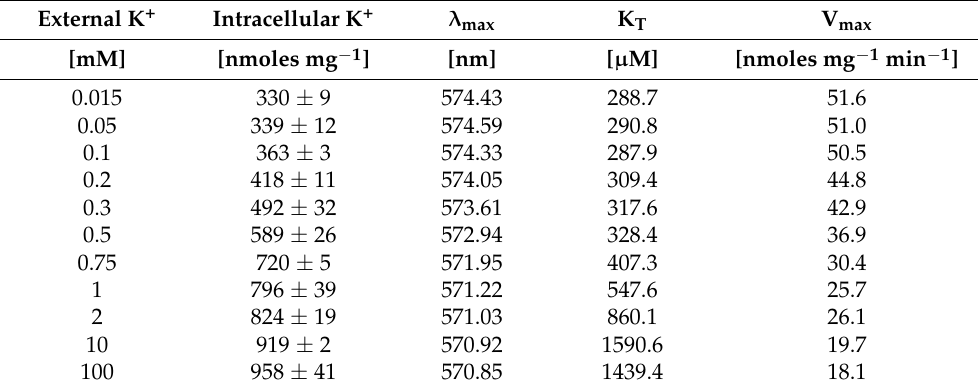
Table 1. Correlations among external K + concentration, intracellular K + content, membrane potential and kinetic